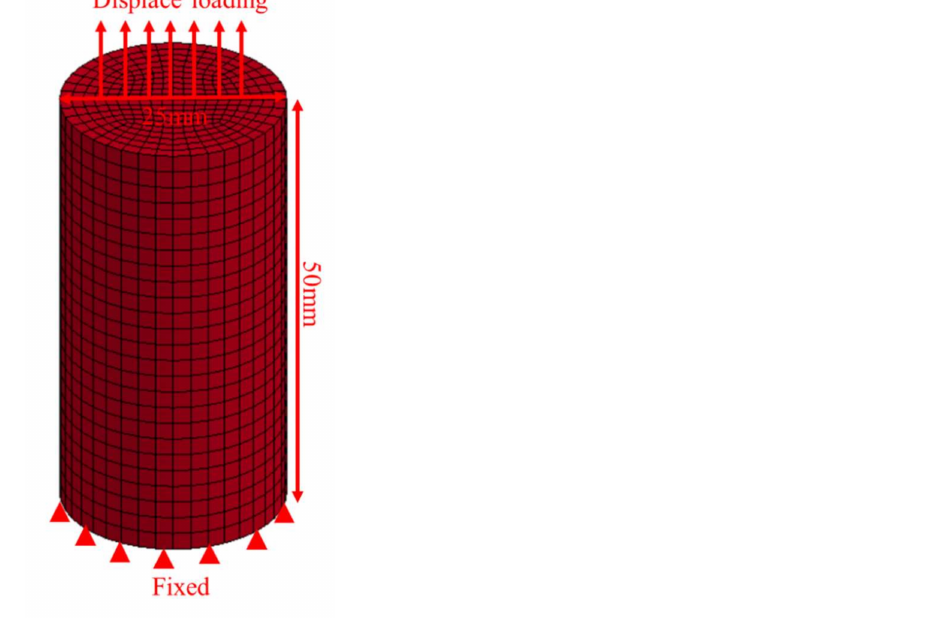
Figure 18. Finite model and boundary condition of uniaxial tension